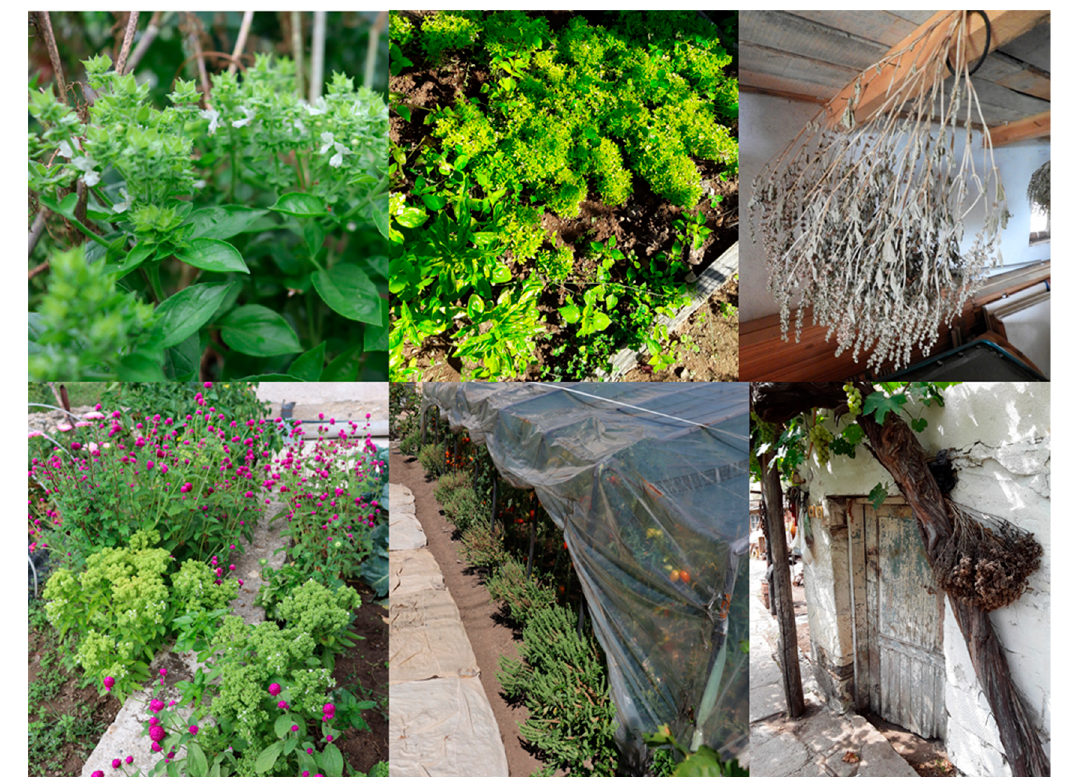
Figure 4. Ocimum basilicum L. in Bulgarian rural livelihoods. Top (left to right): local landrace ‘Zhenski bosilek’ (women’s basil) used as ritual and medicinal plant in Banichan village; Ocimum basilicum L. and O. minimum L. from retail seeds in Central Rhodope Mts.; and the drying of flowering whole plants of O. basilicum. Bottom (left to right): ornamental patch of O. basilicum and Gomphrena globosa L.; O. basilicum sown in front of greenhouse to attract pollinators; and the ritual decoration of O. basilicum for home protection.